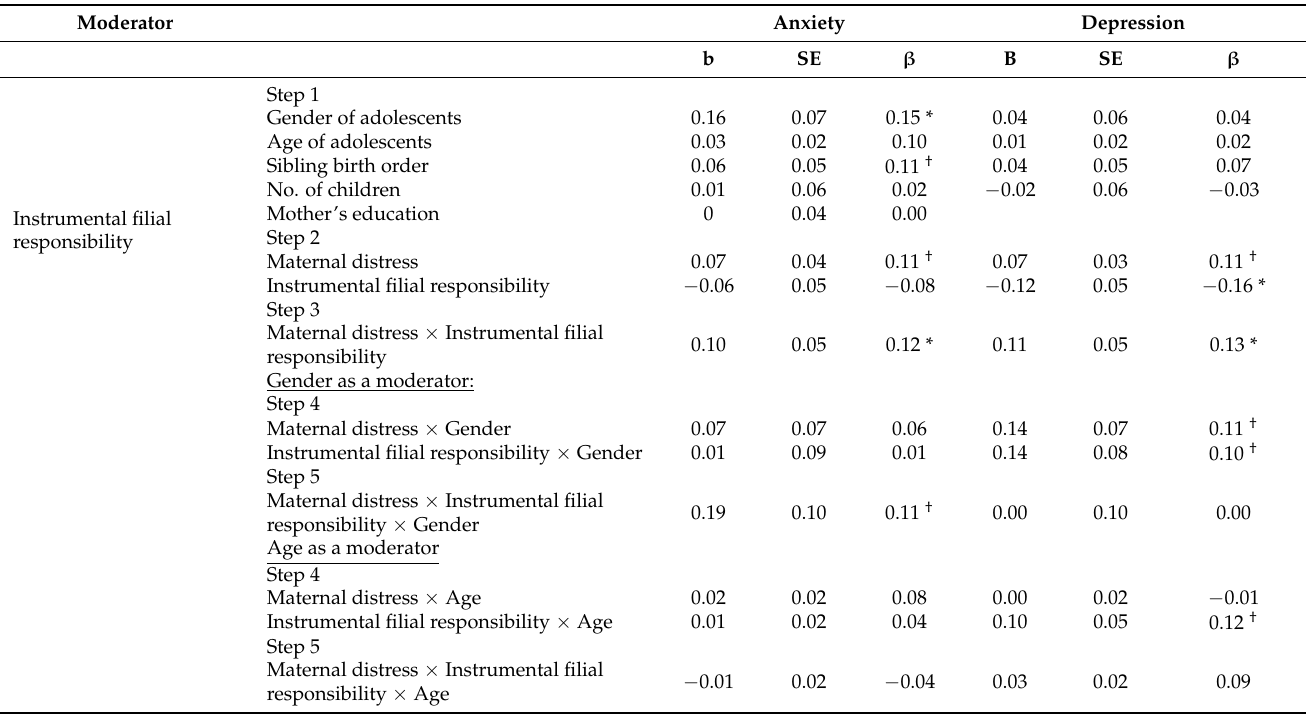
Table 2. Regression of adolescent mental health by instrumental and emotional filial responsibility in the context of maternal